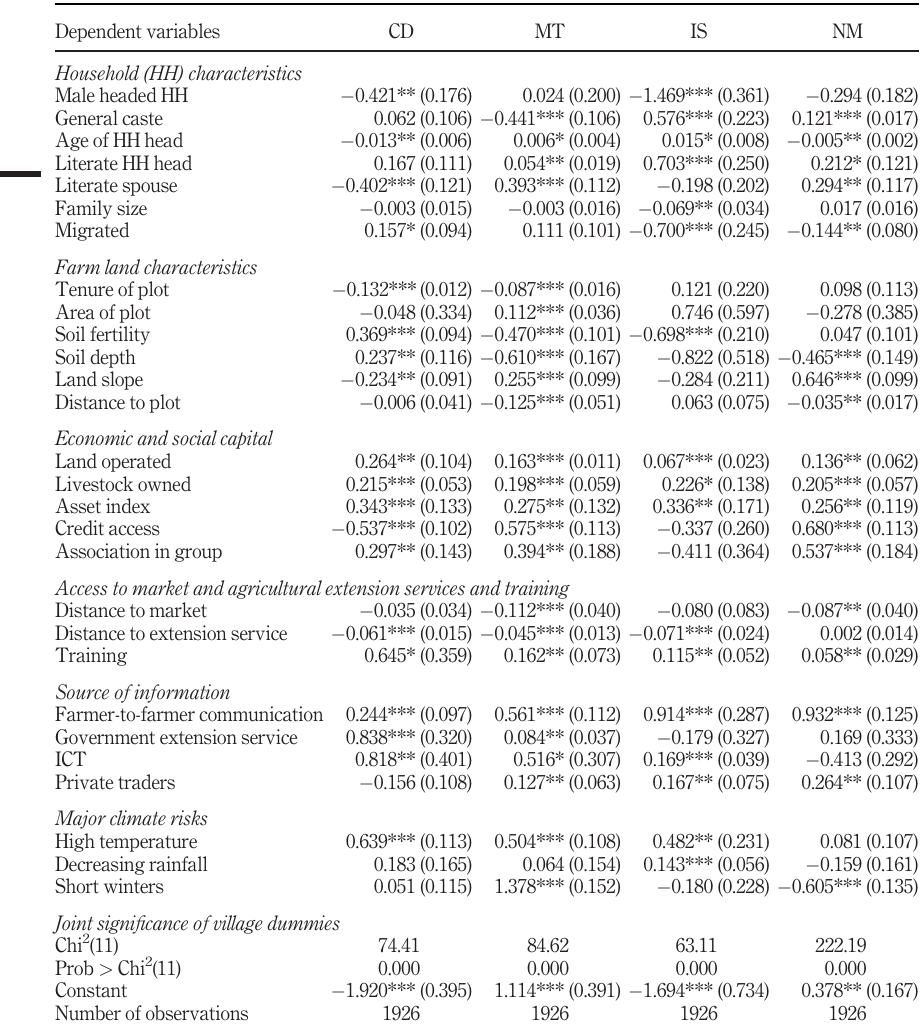
Table IV. Estimates of the MVP